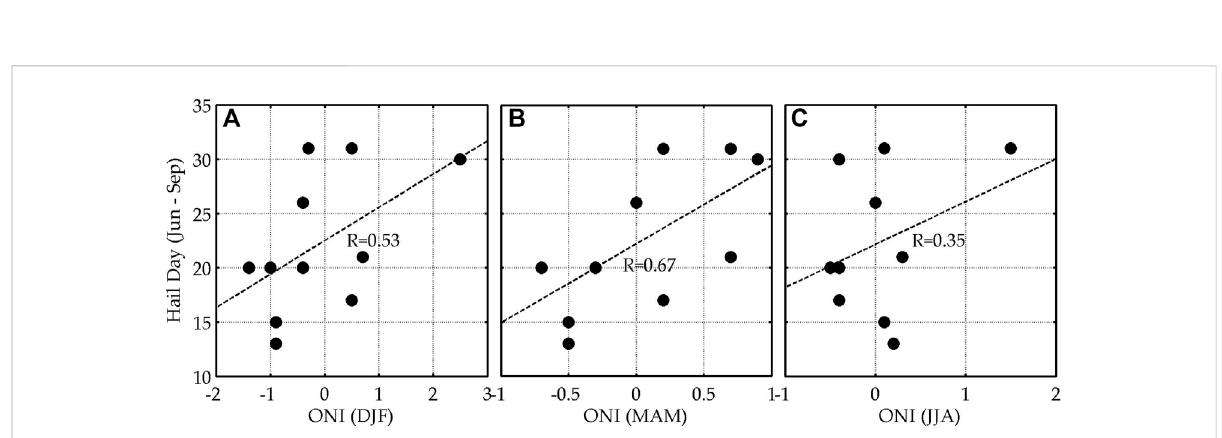
FIGURE 8 The scatterplots of ONI and annual hail days in warm seasons during 2011 – 2021: (A) ONI of DJF; (B) ONI of MAM; (C) ONI of JJA. Dash lines in the plots show the linear fi tting line. Texts in the plots show the correlation coef fi cient between ONI and hail